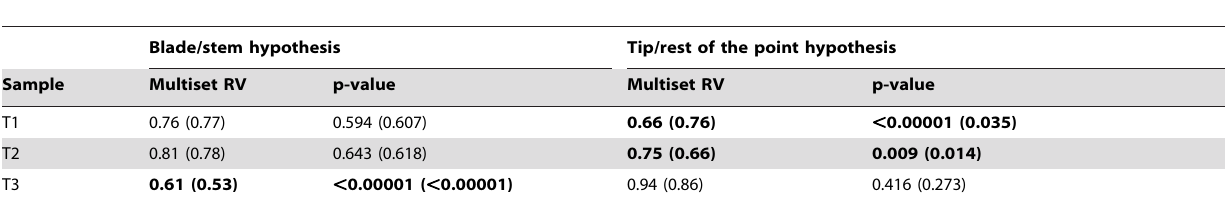
Table 2. Results of the modularity analyses made on the three subsamples defined after Figure 3a.